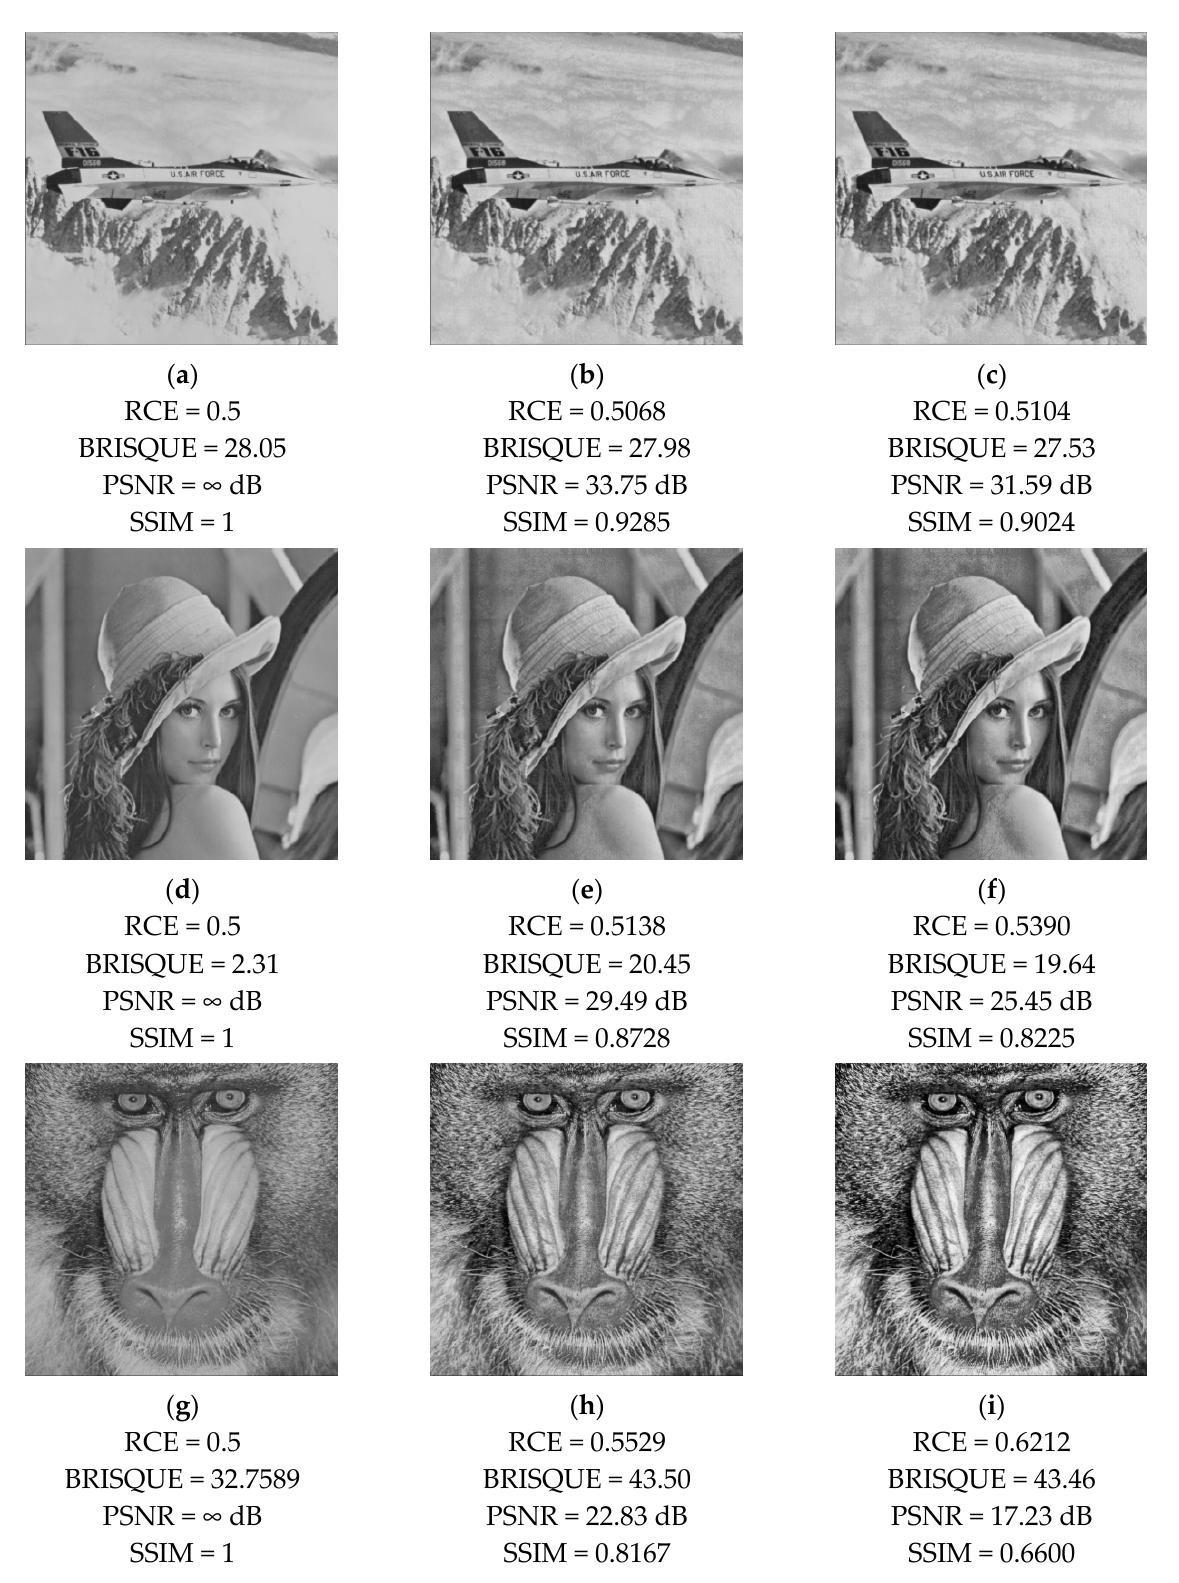
Figure 12. ( a , d , g ) Original images ; ( b , e , h ) enhanced images with internal removal sequence 𝑘𝑖 embedded; ( c , f , i ) enhanced images with internal removal sequence 𝑘𝑖 and binary string 𝐵𝑆 embedded.